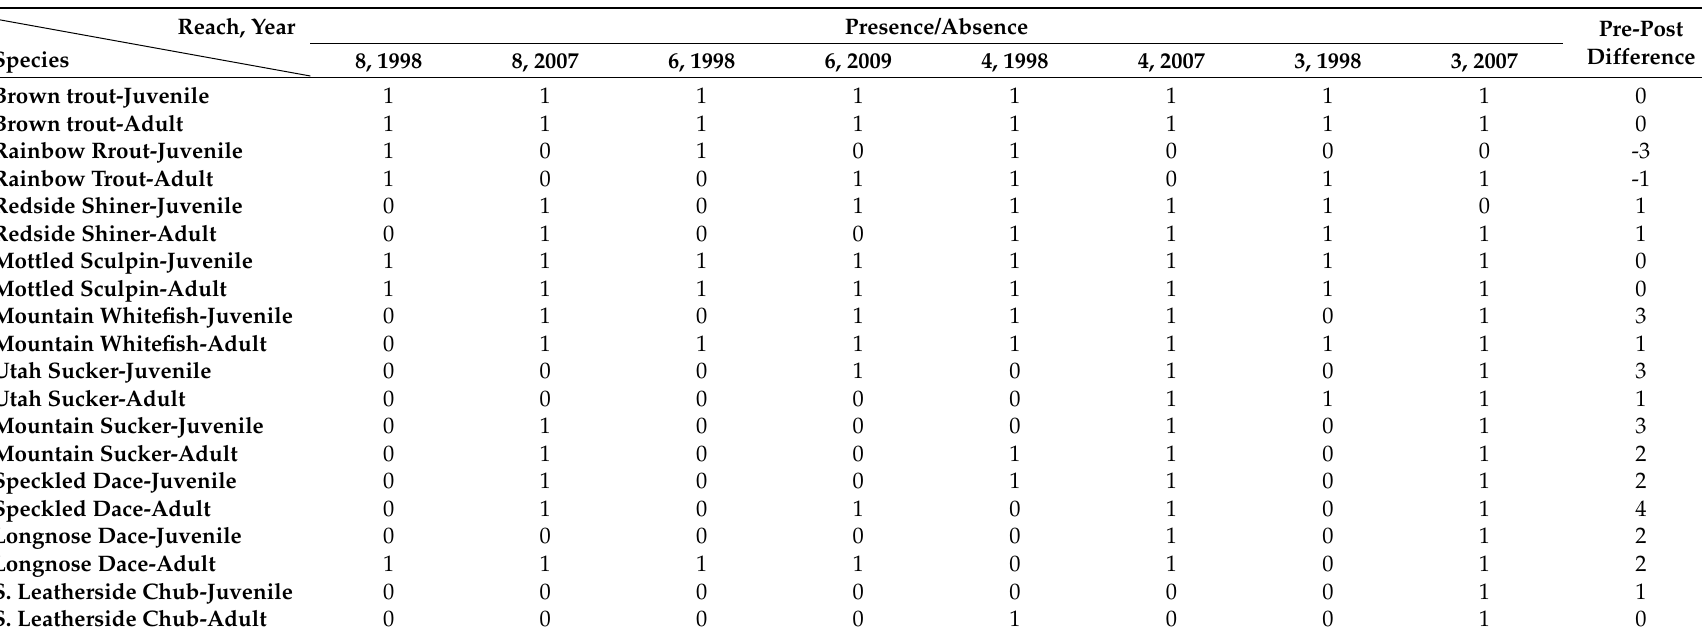
Table 1. Reaches occupied by species-age classes before habitat restoration (1998) and after habitat restoration (2007 and 2009). Bonneville cutthroat trout are not included in this table because they were not present in the entire section either before or after restoration. Presence is indicated with a 1 and absence with a 0. Reach 4 is the reference reach that was not